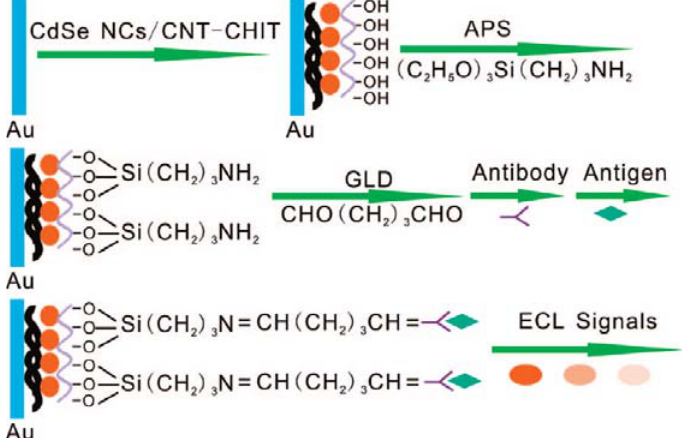
Figure 7. Fabricating Steps of the ECL Immunosensor. Reprinted from Ref [101] with permission from The American Chemical